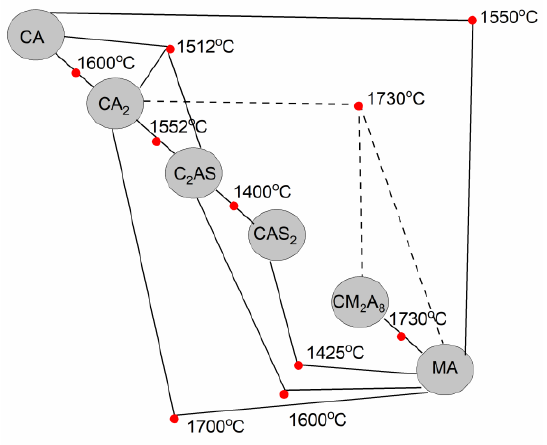
Figure 7. Schematic diagram presenting eutectic temperatures between binary and ternary com-